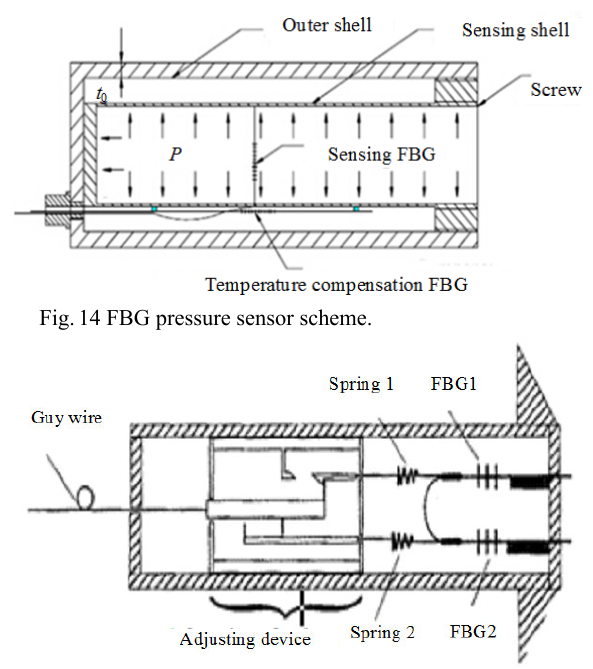
Fig. 15 Structure of the pull-type FBG displacement